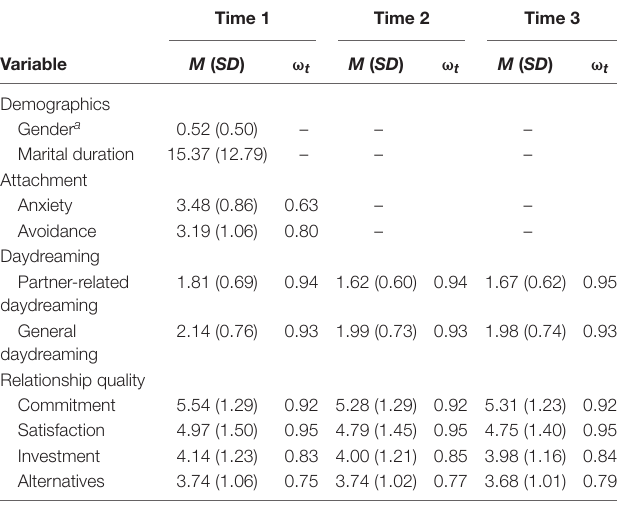
cross-lagged effects.